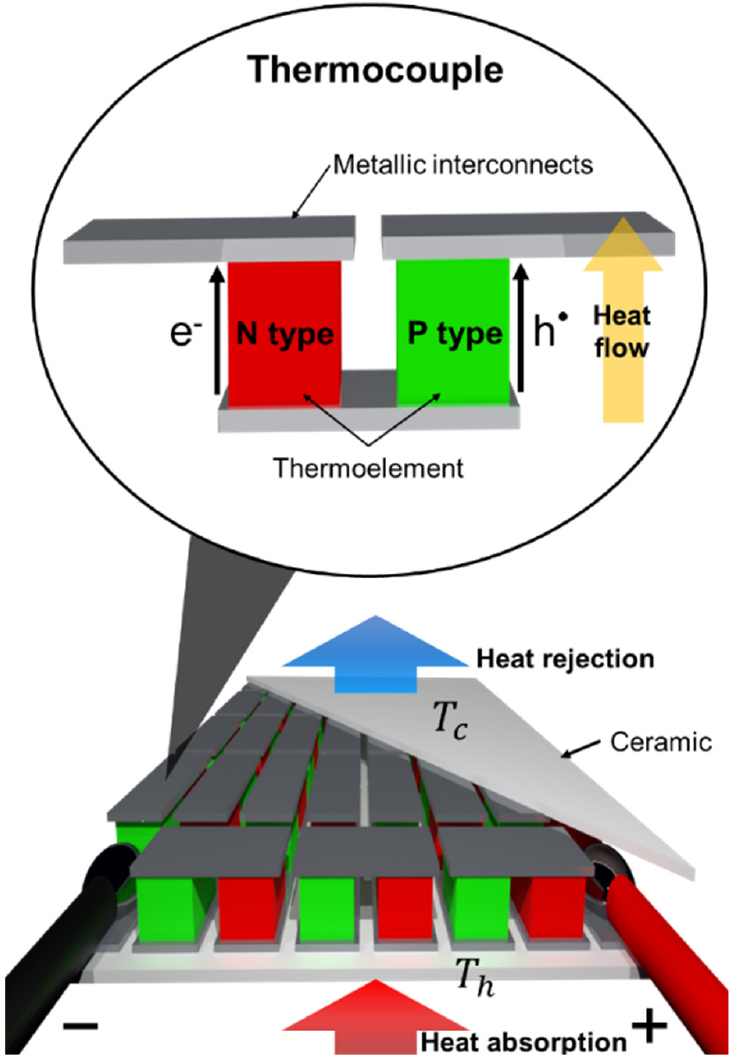
Figure 2. Thermoelectric device illustrating the various components, the direction of heat flow and current for both power generation and cooling. T h and T c are the temperatures of the hot and cold sides, respectively.